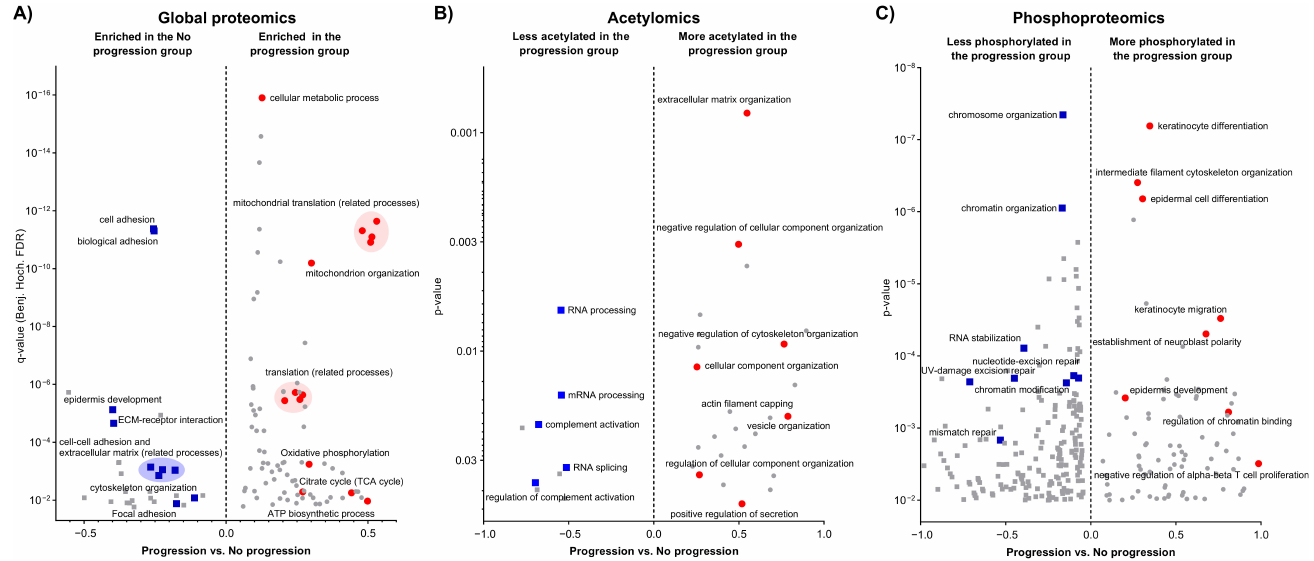
Figure 3. Functional annotation enrichment analysis of the difference at the proteome level ( A ) at the acetylome ( B ), and at the phosphoproteome level ( C ), between the groups of primary melanomas from patients where the disease progressed and those without metastatic event. Highlighted in red and blue are relevant annotations enriched in the Progression and No progression groups